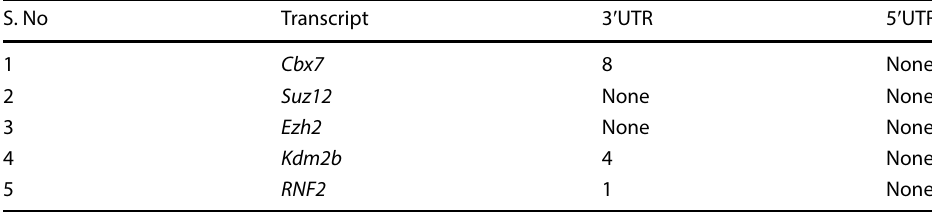
Table 2 Number of SRSF1 binding sites on the UTRs of hub TRs (polycomb complex members) potentially regulating the hub